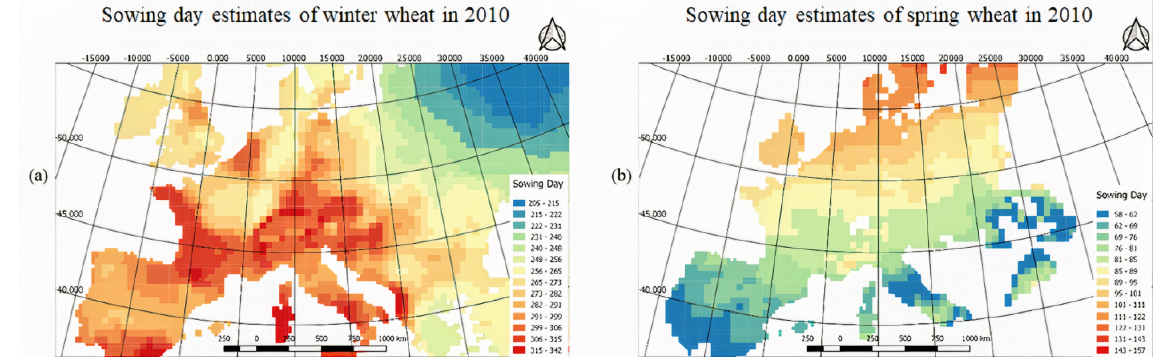
Figure F1. Two examples of estimated sowing days over Europe from the TIMELINES model for winter wheat (a) and spring wheat (b) in